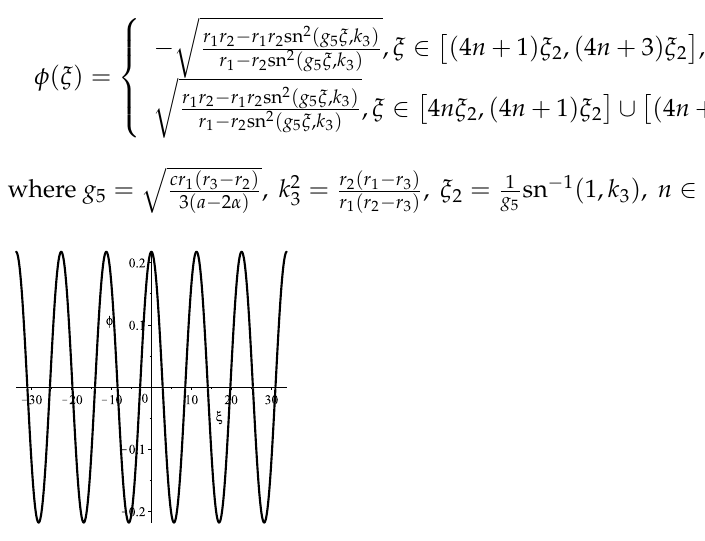
Figure 14. Periodicwave forms of system